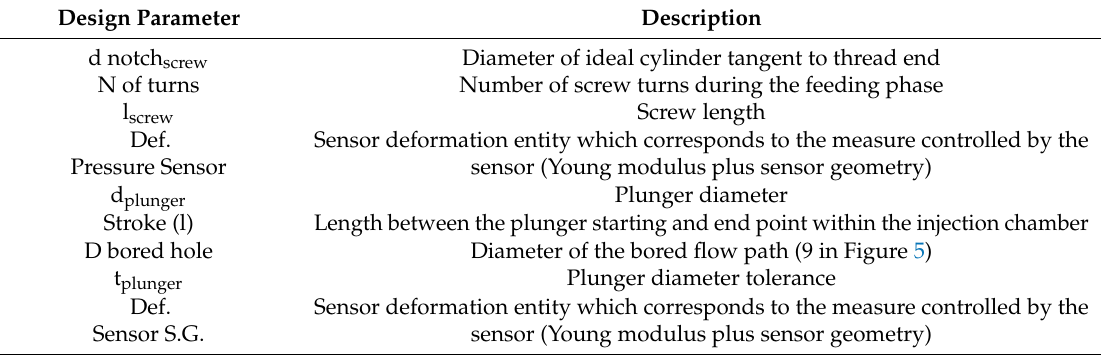
Table 7. List of design parameters of µ IM machine.